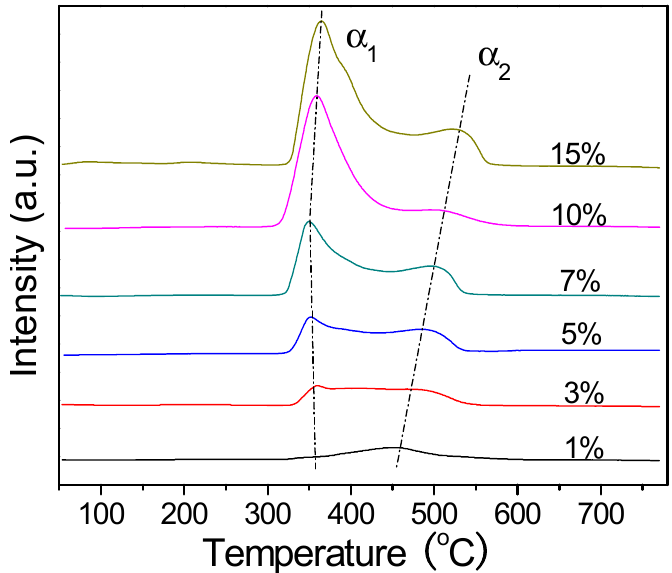
Figure 5. H 2 -TPR profiles of KIT-6-supported NiO catalysts.